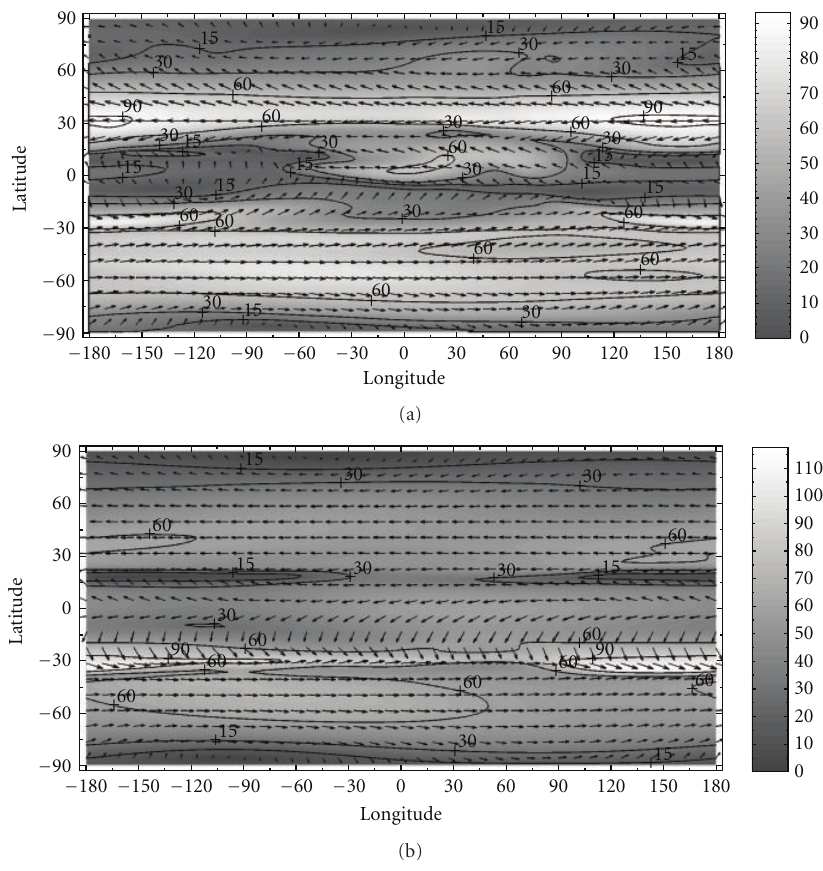
Figure 10: The same as in Figure 9 but at the altitude of 50